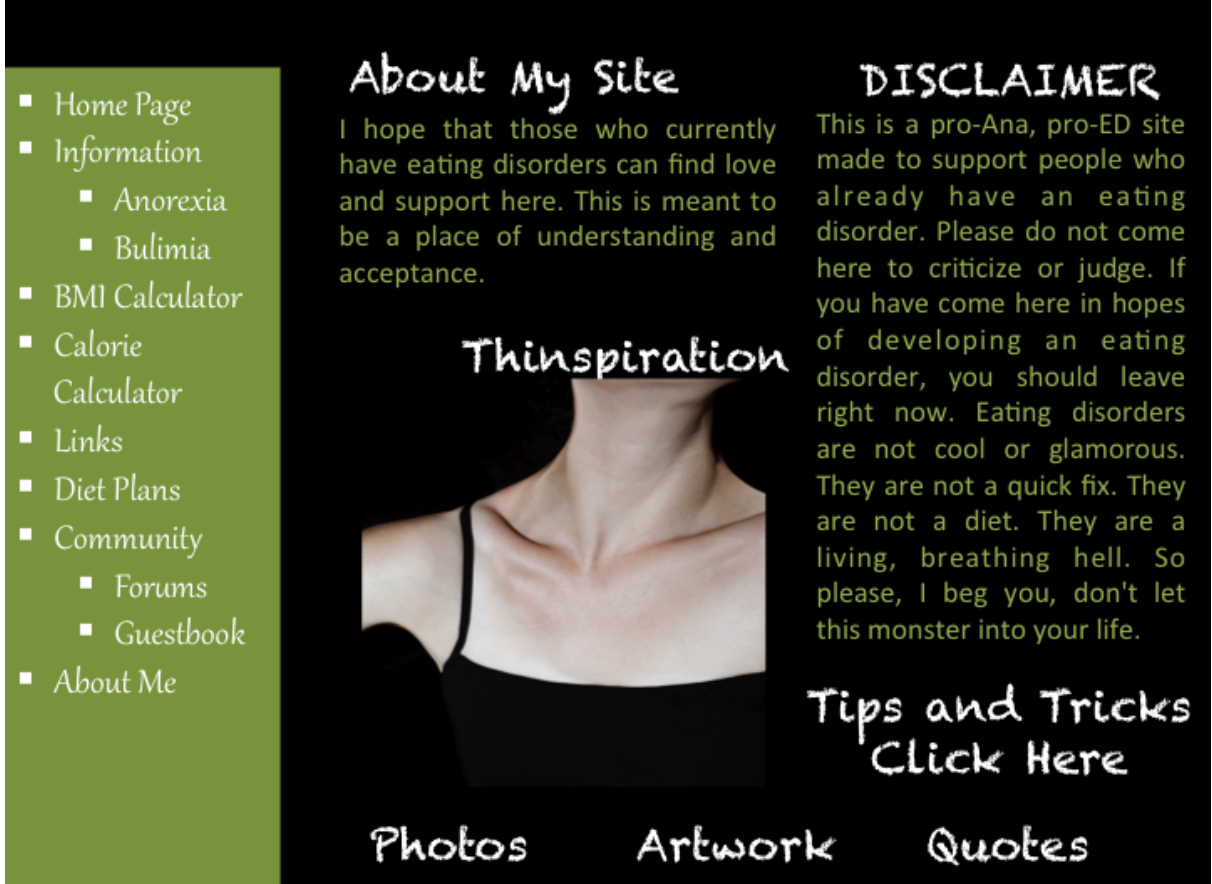
Eating disorder; social network; anorexia nervosa; bulimia nervosa; pro-eating disorder website; pro-anorexia website; pro-bulimia